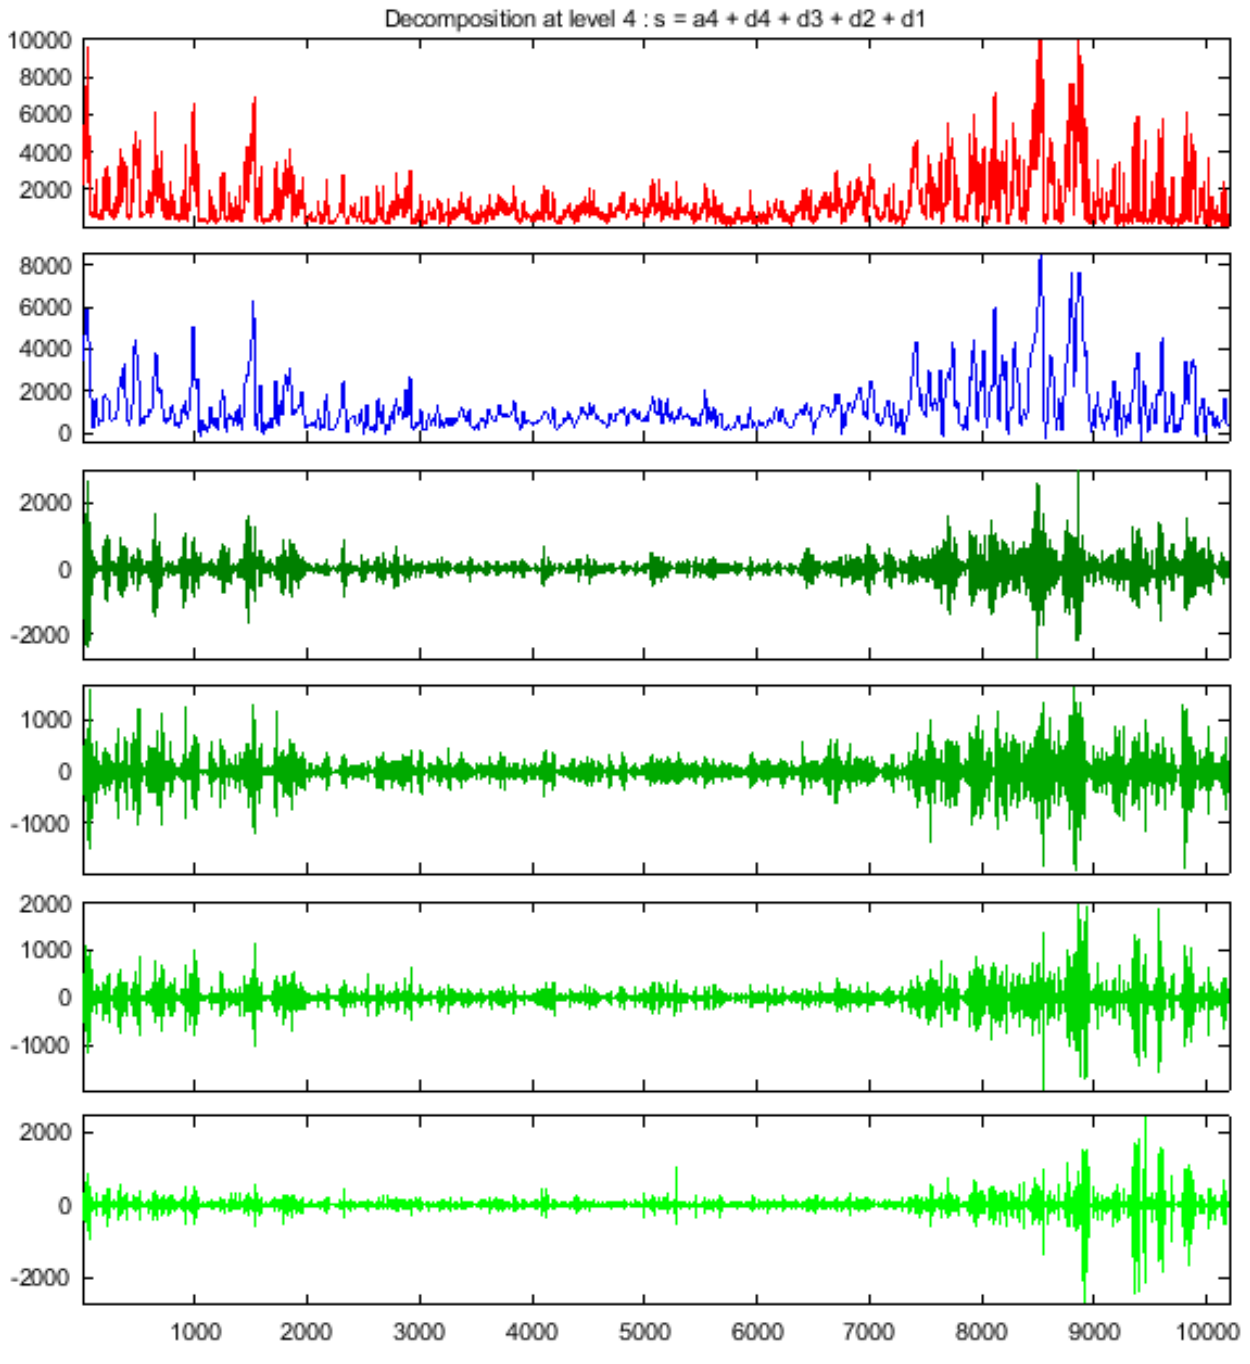
Figure 9. Decomposition of CO hourly data. The X-axis is hours, and the first part in each decomposed feature is a 4, d 4, d 3, d 2, d 1, from top to bottom,